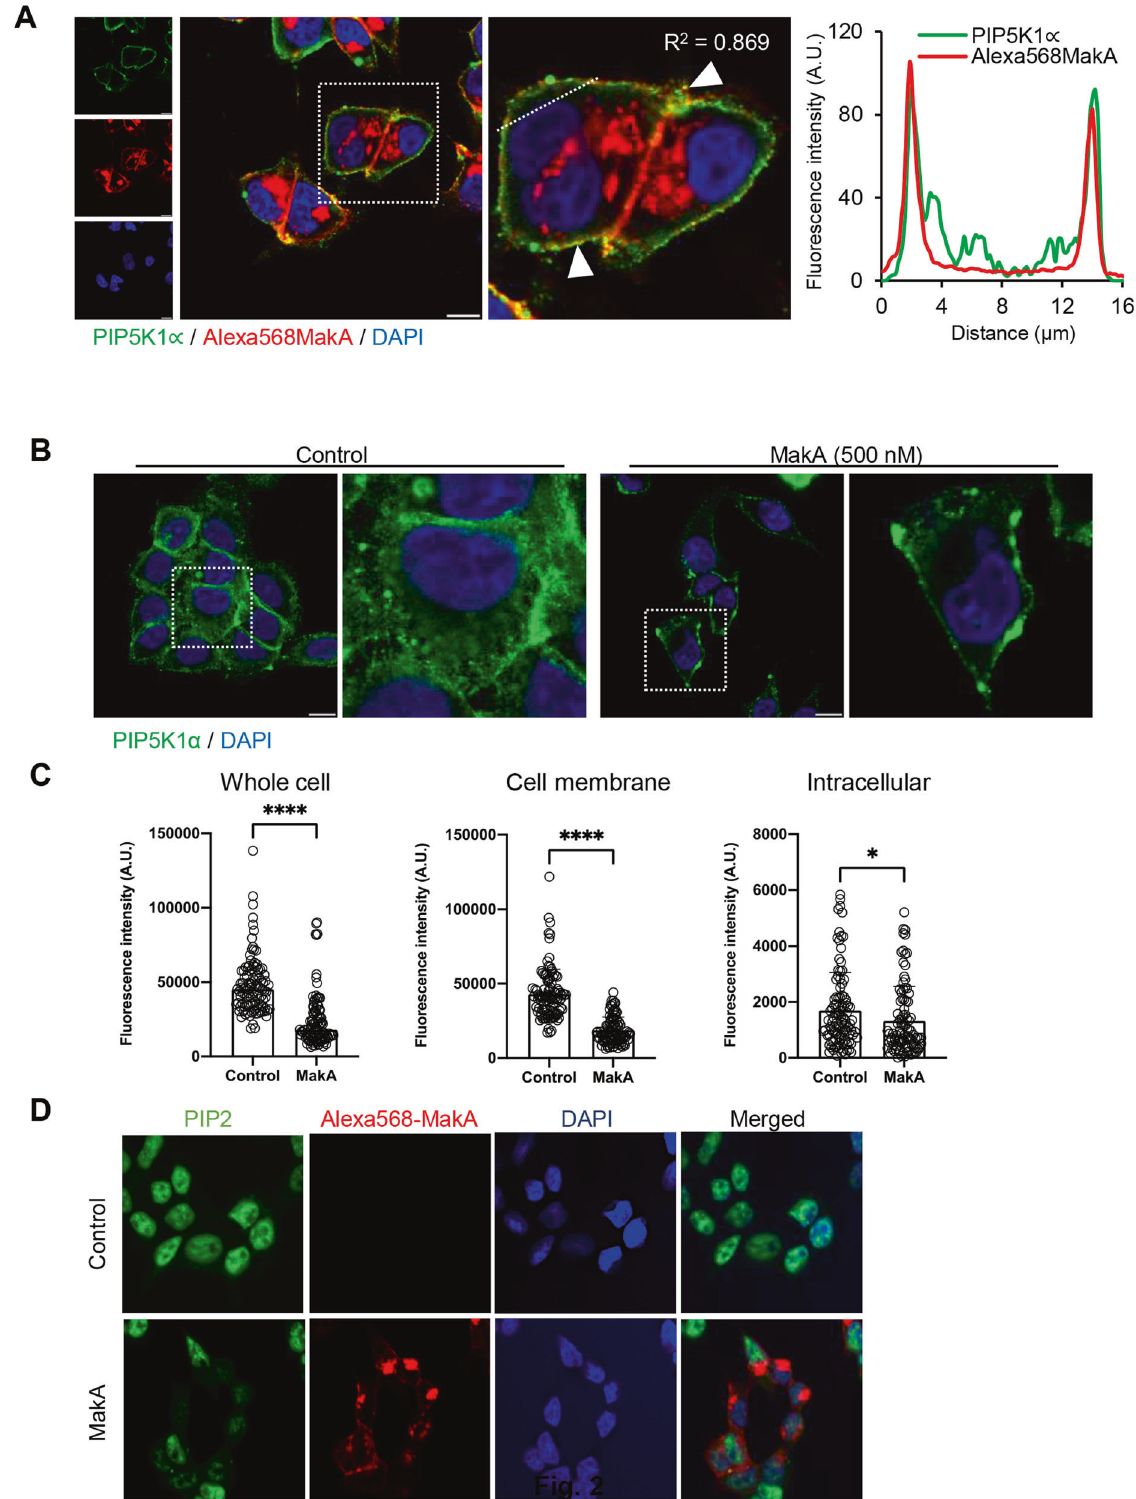
Fig. 2 MakA and PIP5K1 α interaction and reduction of PIP2 level in MakA treated HCT8 cells. A HCT8 colon carcinoma cells were treated with Alexa568MakA (500 nM, red) for 48 h and stained for PIP5K1 α (green) using a speci fi c antibody. Arrowhead (white) indicates cell membrane bound MakA. Nuclei were counterstained with DAPI (blue). Scale bars, 10 μ m. Graph shows fl uorescence intensity pro fi les of the corresponding image in along the dotted white line. Pearson correlation co-ef fi cient was used for calculation of Alexa568MakA (red) co-localization with PIP5K1 α (green) along the cell membrane. B HCT8 cells were treated with Alexa568MakA (500 nM) for 48 h and stained for PIP5K1 α (green) using a speci fi c antibody. Scale bars = 20 μ m. C Histograms indicate quanti fi cation of cells ( n = 90 – 100) presented from experiment in ( B ). * p ≤ 0.05 and **** p ≤ 0.0001. D Confocal microscopic analysis showing the levels of PIP2 in HCT8 cells treated with Alexa568MakA (red). PIP2 was stained using anti-PIP2 mouse antibody (green) and nuclei were counterstained with DAPI (blue). Scale bar = 20 μ m. Cell Death and Disease (2022)